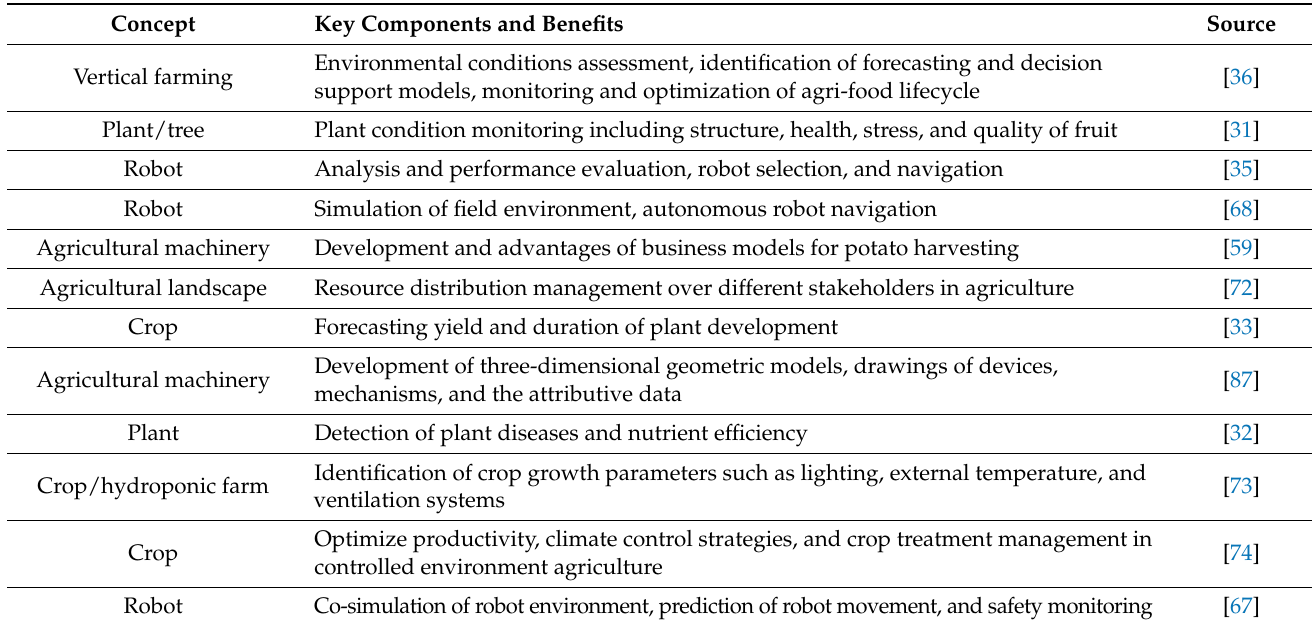
Table 3. Summary of the digital twin in crop production.